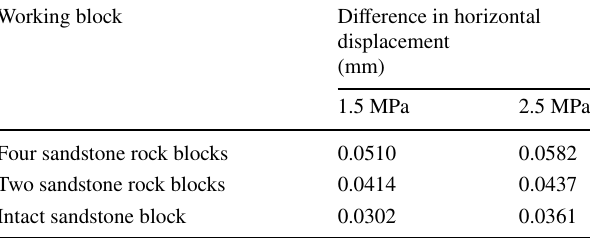
Table 2 Differences in the horizontal displacement of broken blocks under different horizontal impacts Working